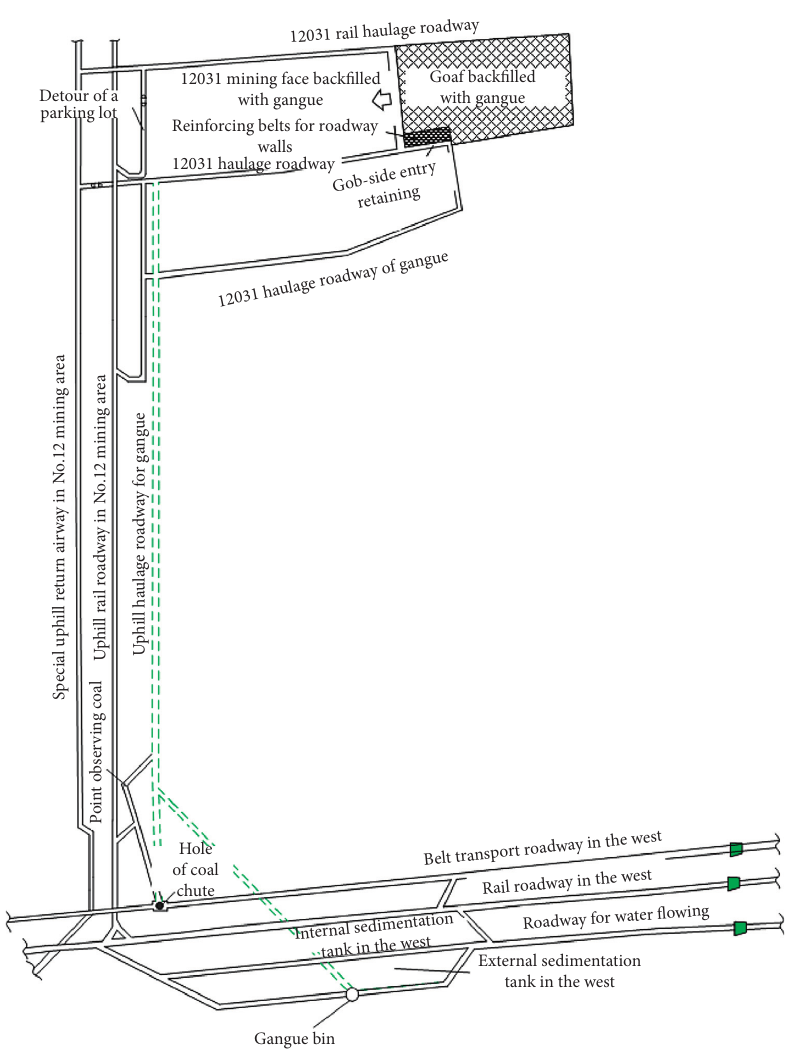
Figure 2: Diagram of layout of roadways in the fully mechanized coal mining face backfilled with